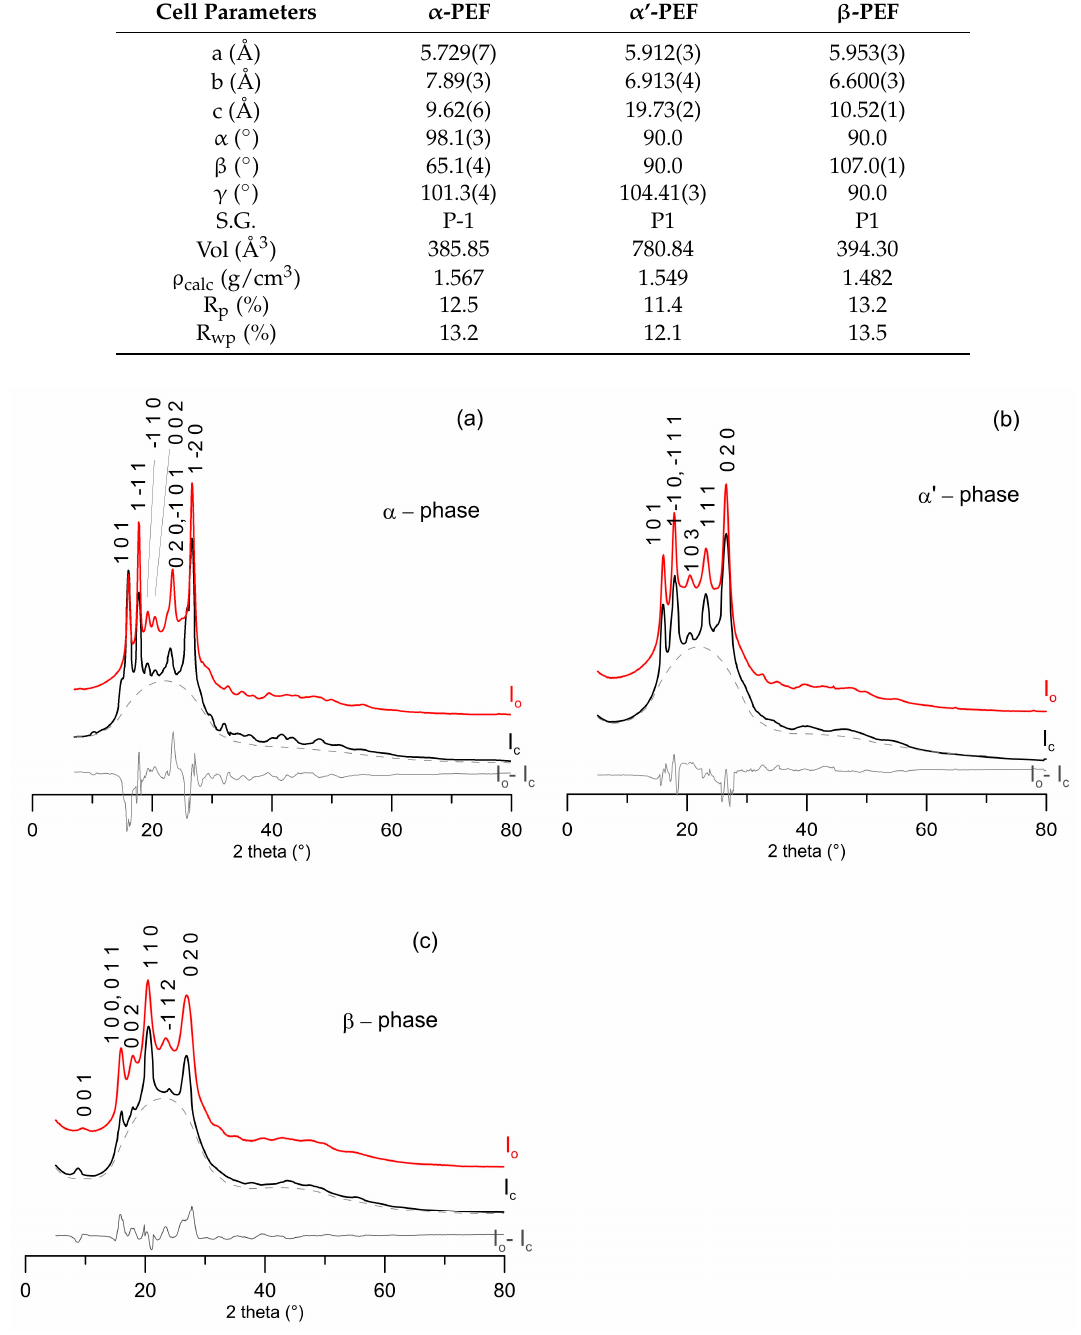
Table 1. Structural data; estimated standard deviations (e.s.d.) in parentheses.